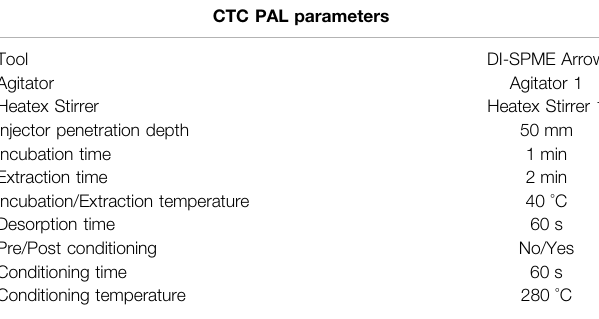
TABLE 2 | Optimized and fi nal DI-SPME Arrow